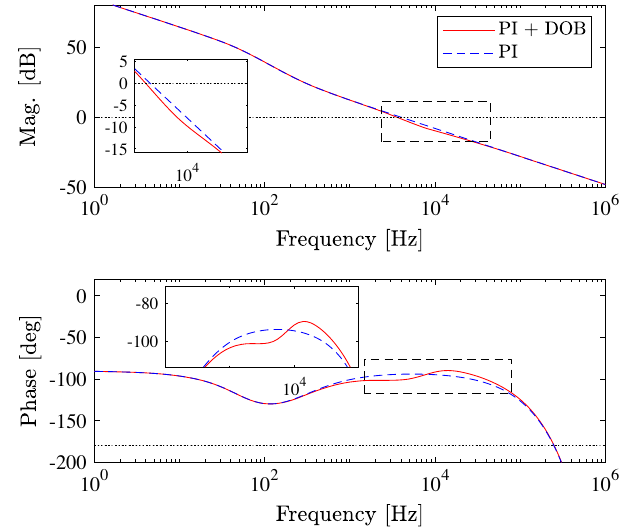
FIG. 14. Comparison of the bode plots of the sum of all loop gains in the case of the PI þ DOB control and PI individual control. The magnitude response in the two cases almost overlap. The maximum phase lag caused by DOB control is approx- imately 6